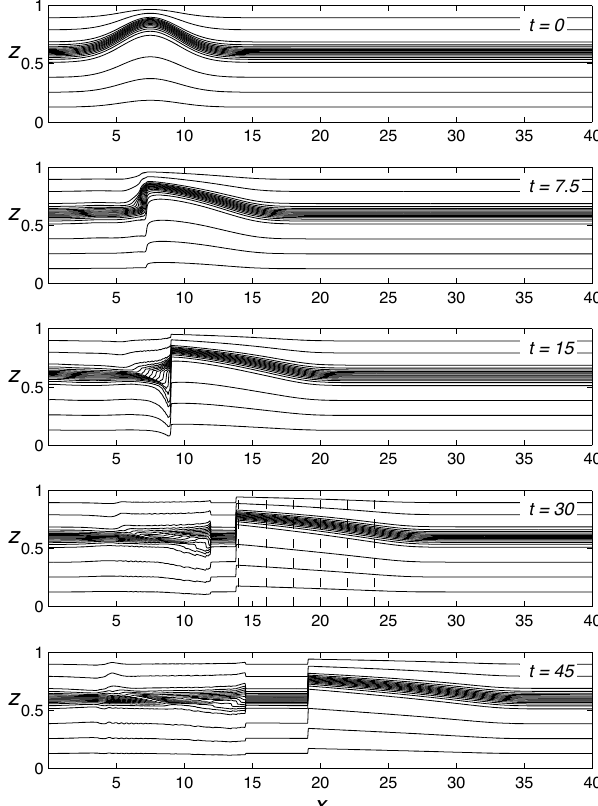
Fig. 6. Interface evolution from the M = 20 representation of the stratification Eq. (27) with z 0 = 0 . 6 and λ = 15. The initial condi- tion is from Eqs. (28) and (29) with a 0 = 0 . 25 and b = 1 / 3. The vertical dashed lines at t = 30 indicate positions where c in Fig. 7a are